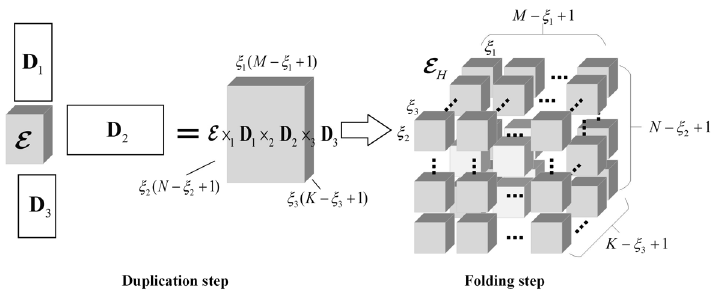
Fig. 3 MDT processing for a